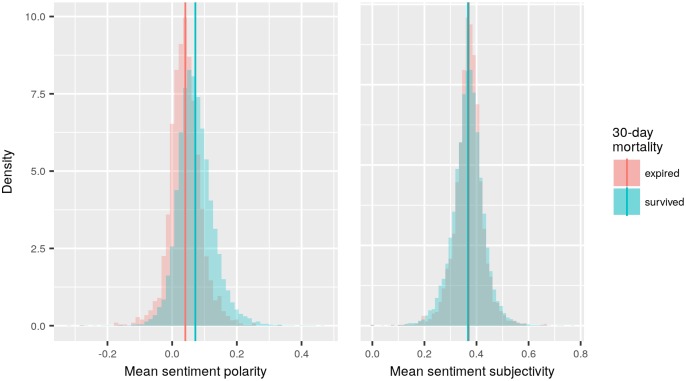
Density histograms of mean sentiment polarity (Left) and subjectivity (Right) scores for patients that expired within 30 days and patients that survived.